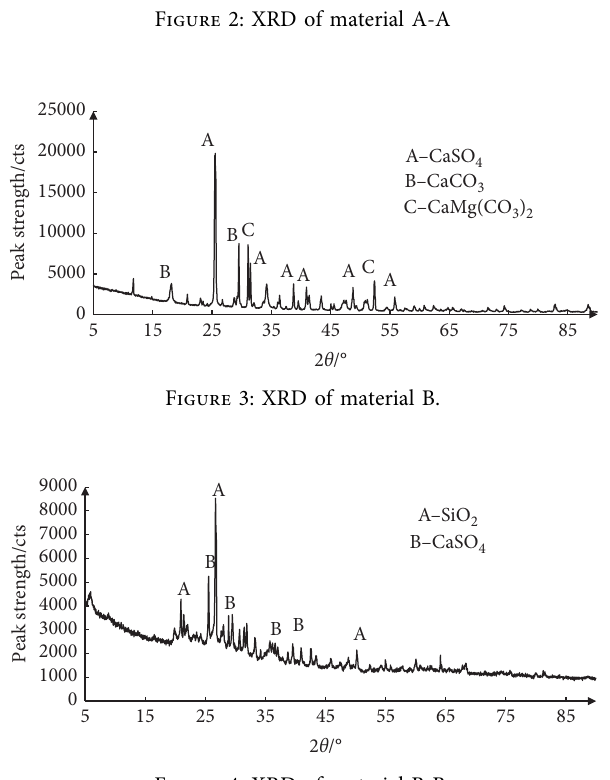
Figure 2: XRD of material A-A